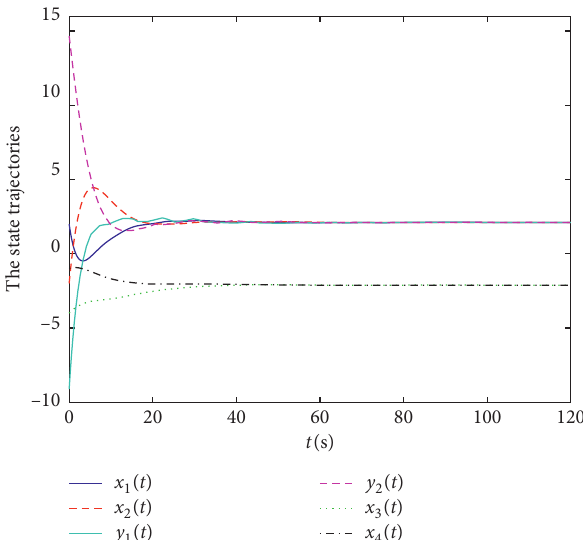
Figure 4: The state trajectories when τ � 0.